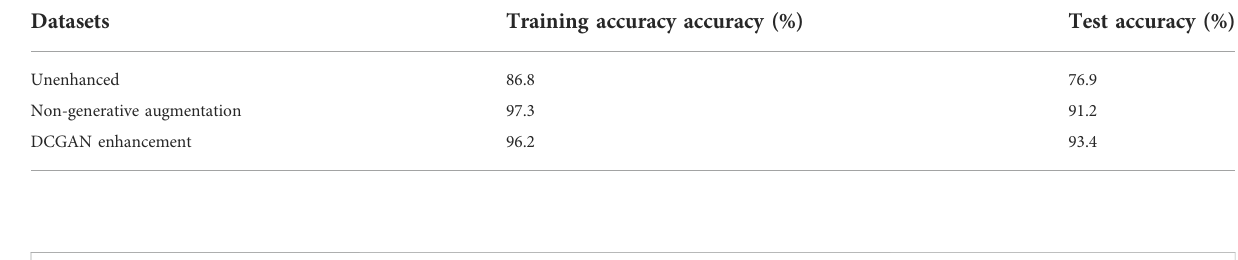
TABLE 3 Accuracy comparison of fl uorescent penetration detection data sets.